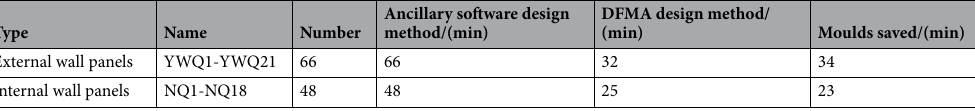
Table 3. Number of mating moulds.